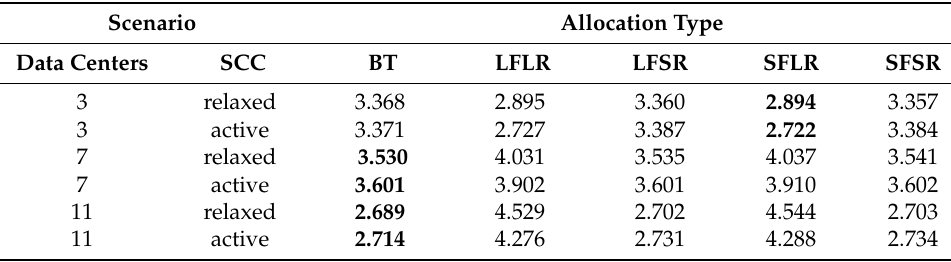
Table 2. Ranking of various grooming strategies for the FF-TG and kFF-TG algorithms.